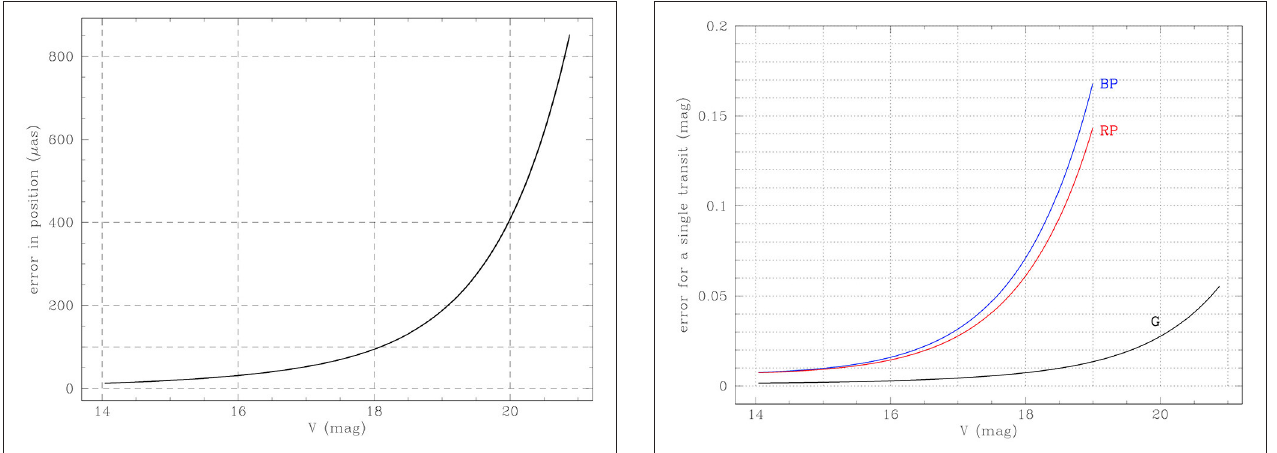
redshifts between 0.5 and 3.5. Vertical stripe at ∼ 8,600 Å